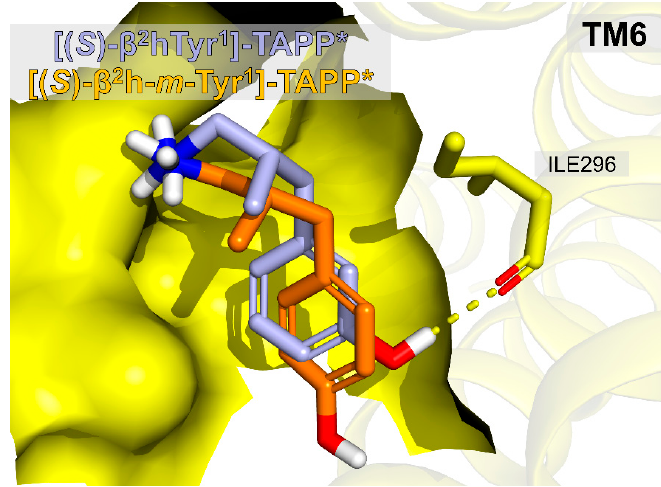
Figure 6. Comparison of binding poses of compounds [( S )- β 2 hTyr 1 ]-TAPP*, 13 (orange) and [( S )- β 2 h- m -Tyr 1 ]-TAPP*, 14 (light blue). Only the first residues of the peptides are shown. The receptor is partially represented as a surface representing the binding site. Only Ile296 side-chain (yellow sticks) is explicitly shown.